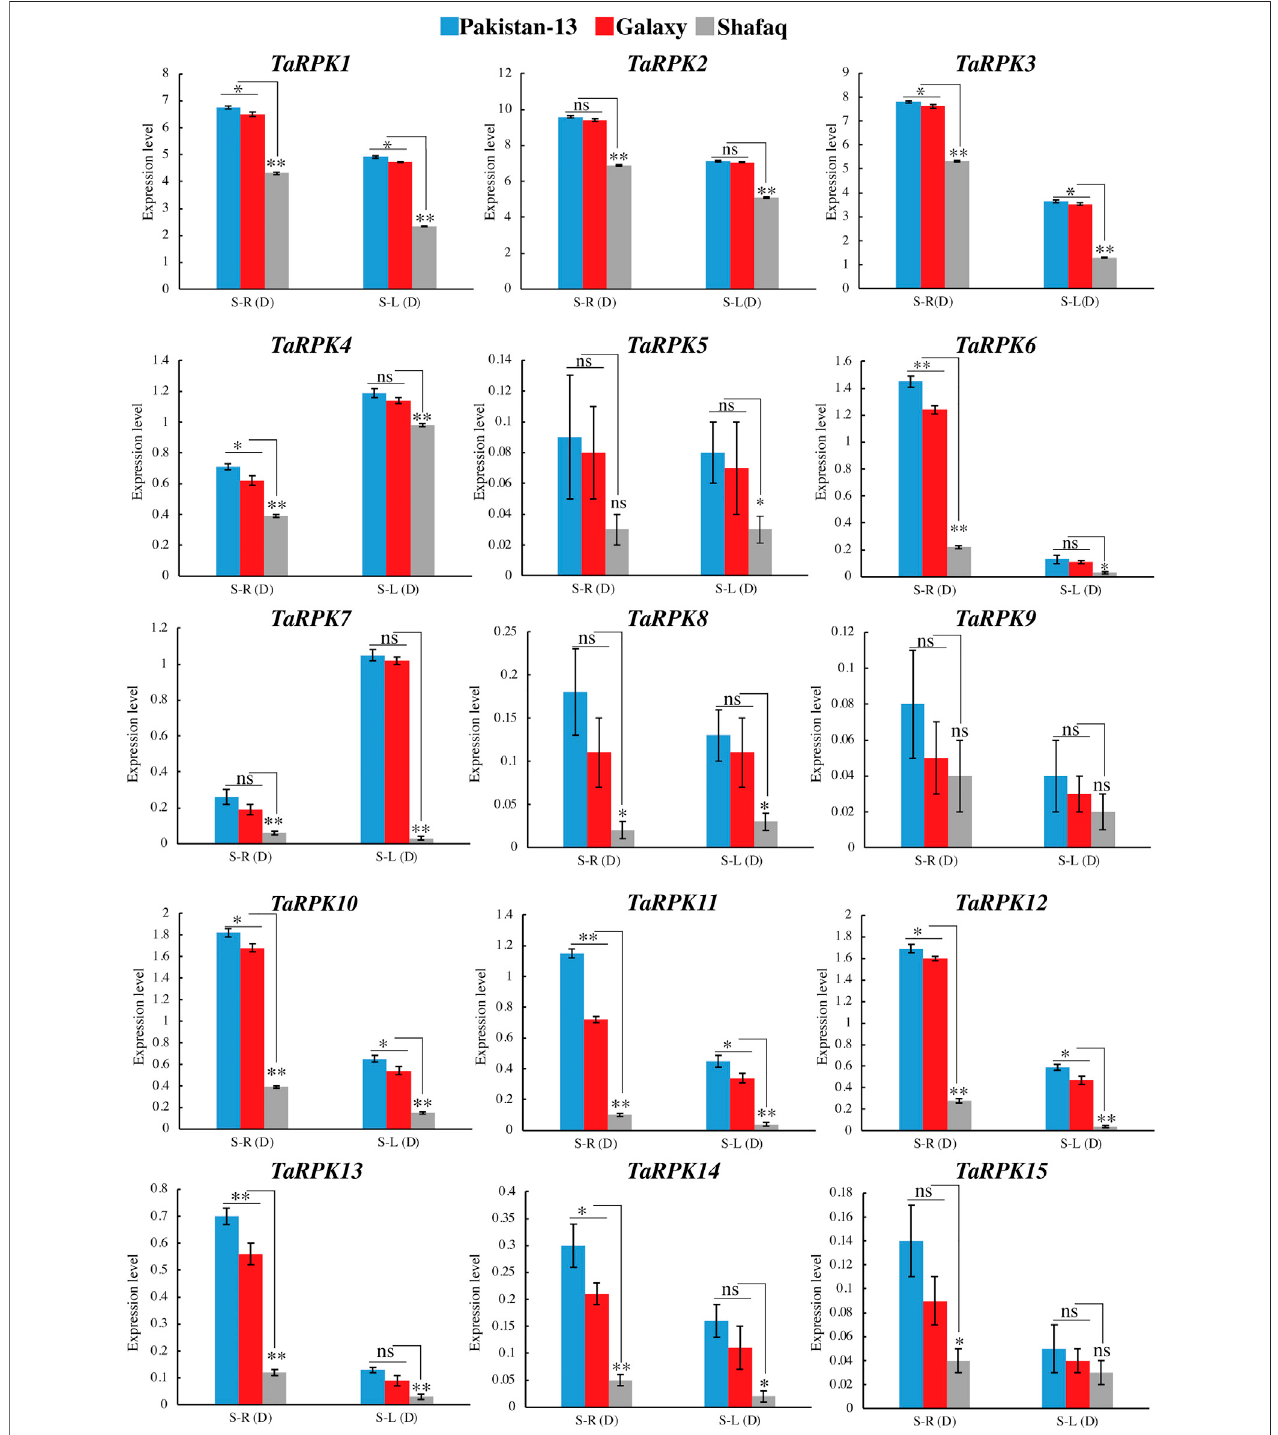
FIGURE 10 | Expression pro fi ling of TaRPK1 genes under 20% PEG stress in Pakistan 13, Galaxy, and Shafaq varieties. Expressions of TaRPK1 genes were determined in root (S – R) and leave (S – L) at the seedling stage (S). Error bars denote standard errors of three biological replicates. Signi fi cance was assessed by using a t -test (* p < 0.05, ** p < 0.01, and ns = non-signi fi cant).